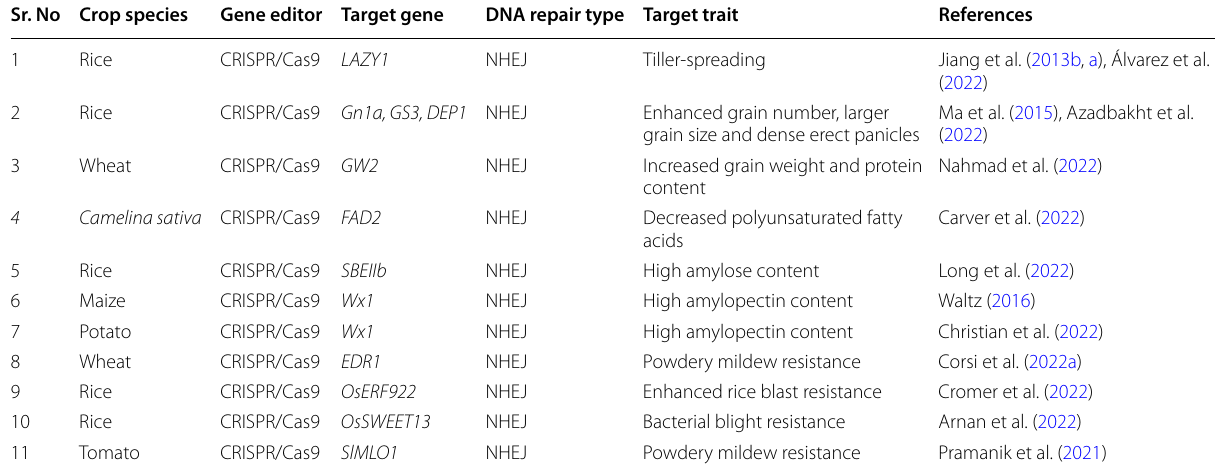
Table 5 List of some genes targeted by CRISPR/Cas9 Sr. No Crop